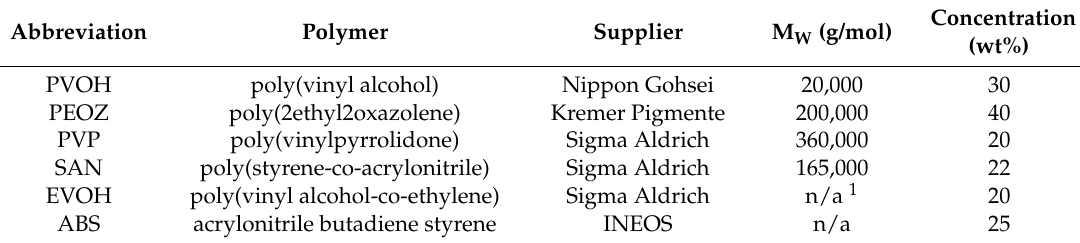
Table 1. Polymers used for electrospinning and their respective molecular weight and concentration in the polymer solution.